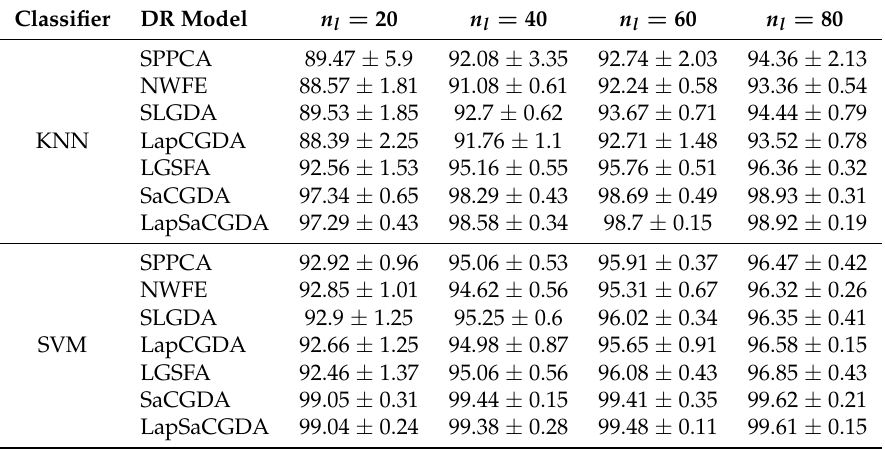
Figure 8. Classification accuracy (OA) w.r.t. different dimensionality of the projection space on the Salinas data: ( a ) OAs based on KNN; ( b ) OAs based on SVM. Table 5. Classification results with different numbers of training data on the Salinas data (OA ± STD